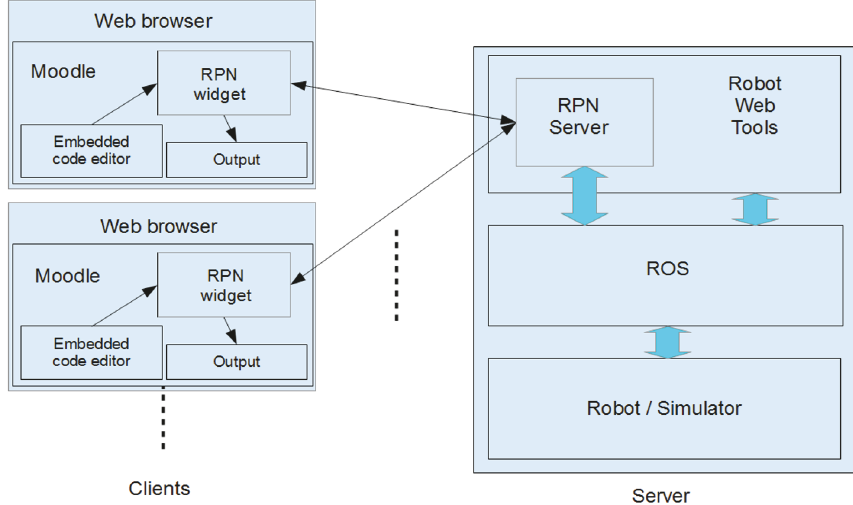
Figure 2: Block diagram of the